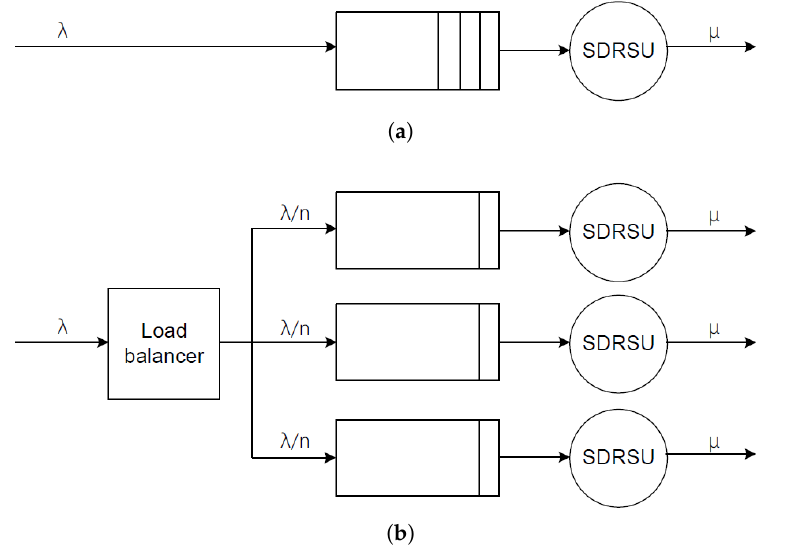
Figure 5. Delay model based on queuing theory. ( a ) Traditional network. ( b ) Software-Defined Networking (SDN)